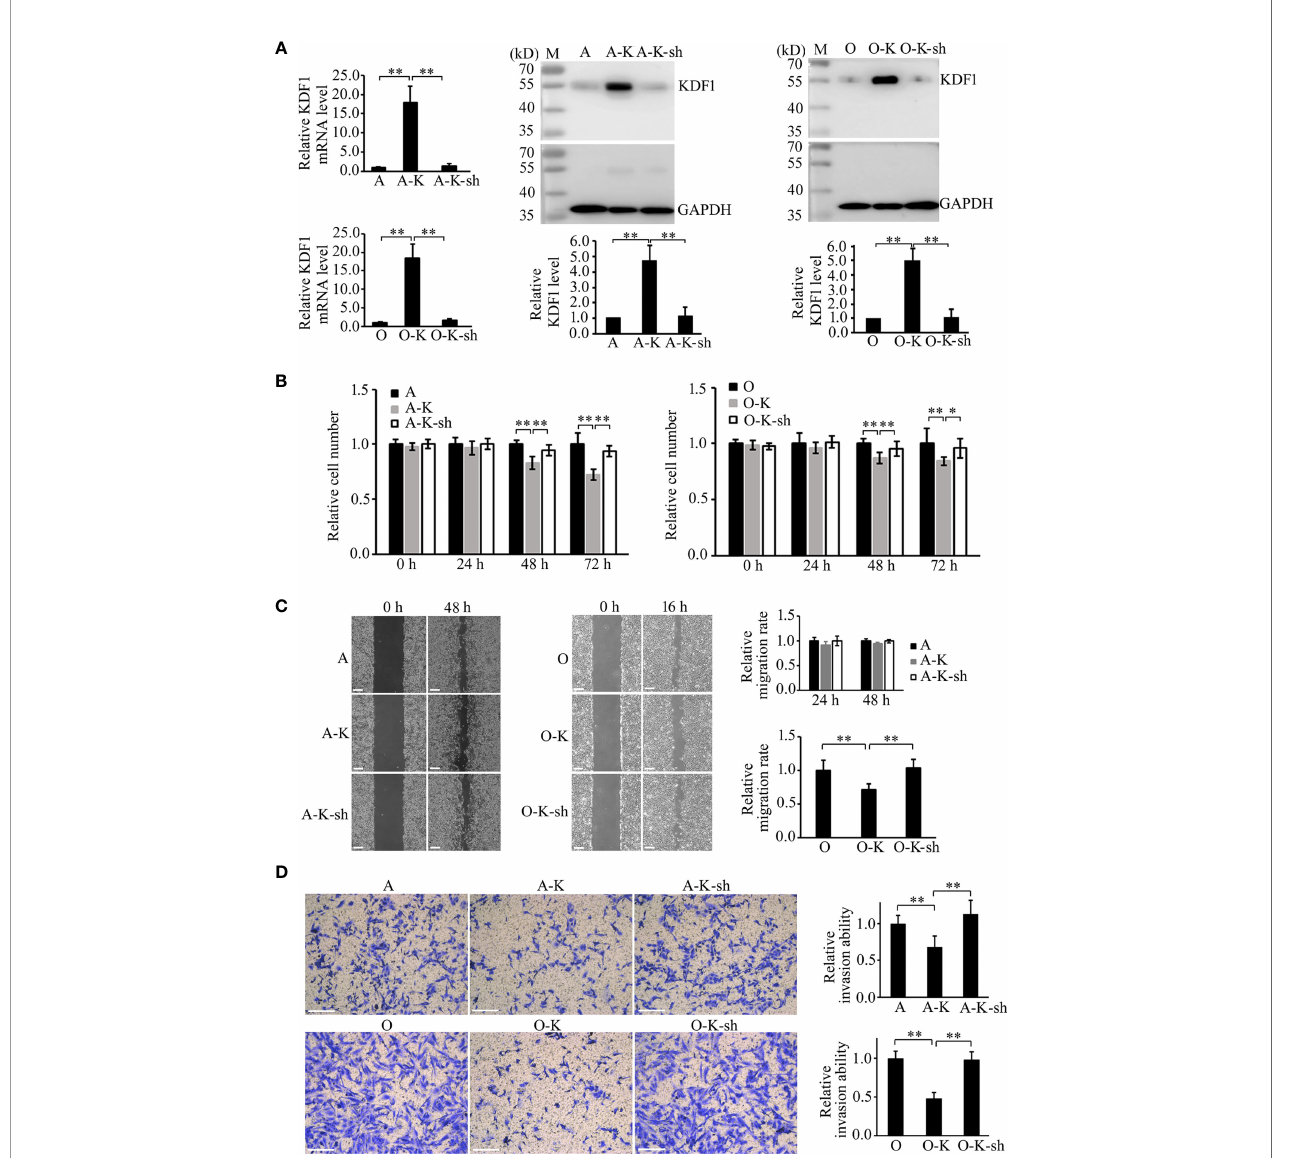
FIGURE 6 | Knockdown of KDF1 reversed the effect of KDF1 overexpression on the ccRCC cell ’ s proliferation, migration and invasion. A recombinant KDF1 shRNA expression lentivirus was used to knock down the expression of KDF1 in the KDF1 overexpression ccRCC cells. The knockdown of KDF1 expression was con fi rmed by quantitative RT-PCR and Western blot analysis (A) and the in fl uence of KDF1 knockdown in the proliferation (B) , migration (C) and invasion (D) of the KDF1 overexpression ccRCC cells were evaluated by using CCK-8, wound healing and Matrigel invasion chamber methods. All the experiments were repeated at least three times. A, untransduced ACHN cells; A-K, KDF1 overexpression ACHN cells; A-K-sh, the KDF1 knockdown A-K; O, untransduced 786-O cells; O-K, KDF1 overexpression 786-O cells; O-K-sh, the KDF1 knockdown O-K; *p < 0.05; **p < 0.01. Scale bar,